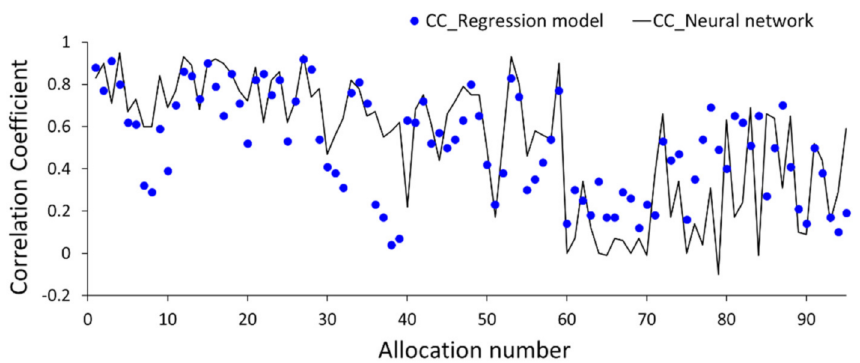
Figure 8. Correlation coefficient versus allocation